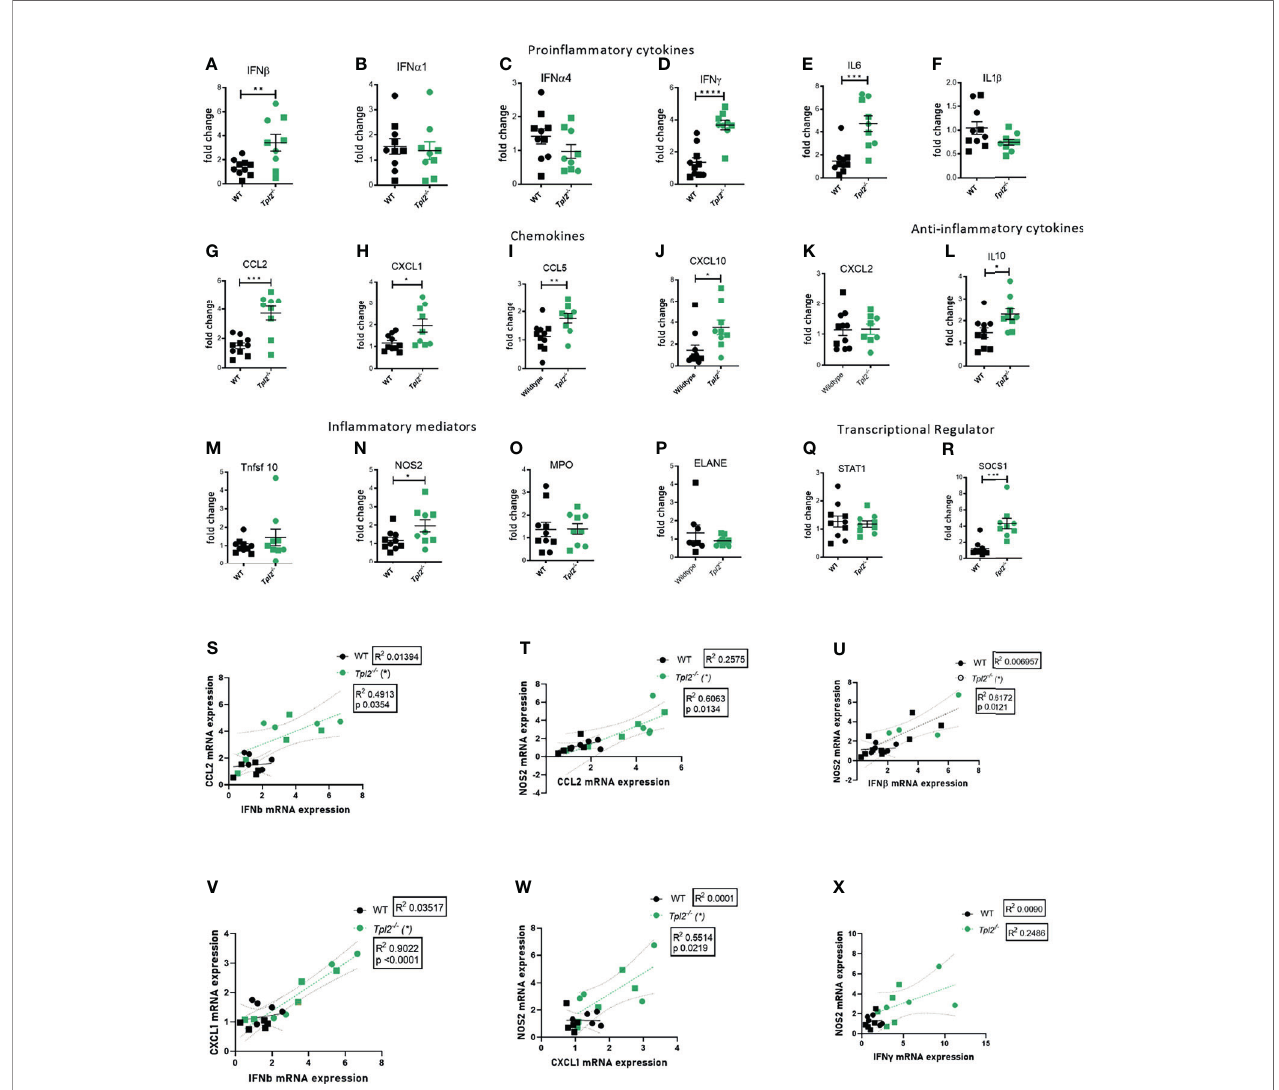
FIGURE 4 | IncreasedmRNAexpressionofproin fl ammatorymediatorsinlungs ofin fl uenza-infected Tpl2 -/- miceat7dpi. (A – R) WT(n= 10)and Tpl2 -/- (n=9) micewere infectedintranasallywith10 4 pfuofin fl uenzax31andeuthanizedat7dpi.Thelungs werehomogenized,and RNAwasextractedandanalyzedforgene expressionbyreal-time PCRfor pro-in fl ammatorycytokines (A – F) , chemokines (G – K) , anti-in fl ammatorycytokine (L) , in fl ammatorymediators (M – P) andtranscriptionalregulators (Q, R) .Unpaired student ’ s t -test; *p<0.05,**p<0.01,***p<0.001, ****p<0.0001). (S) Pearson ’ scorrelationofCCL2mRNA versus IFN- b mRNAonday7. *p<0.05 (T) Pearson ’ scorrelationof NOS2mRNA versus CCL2mRNA onday7. *p<0.05 (U) Pearson ’ scorrelationofNOS2mRNA versus IFN- b mRNAonday7. *p<0.05 (V) Pearson ’ s correlationofCXCL1 mRNA versus IFN b mRNAonday7. *p<0.05 (W) Pearson ’ scorrelationofNOS2 mRNA versus CXCL1mRNA onday7. *p<0.05 (X) Pearson ’ scorrelationofNOS2mRNA versus IFN- g mRNAonday7. *p<0.05Dataarerepresentativeof2experiments. Squaresrepresent male mice,